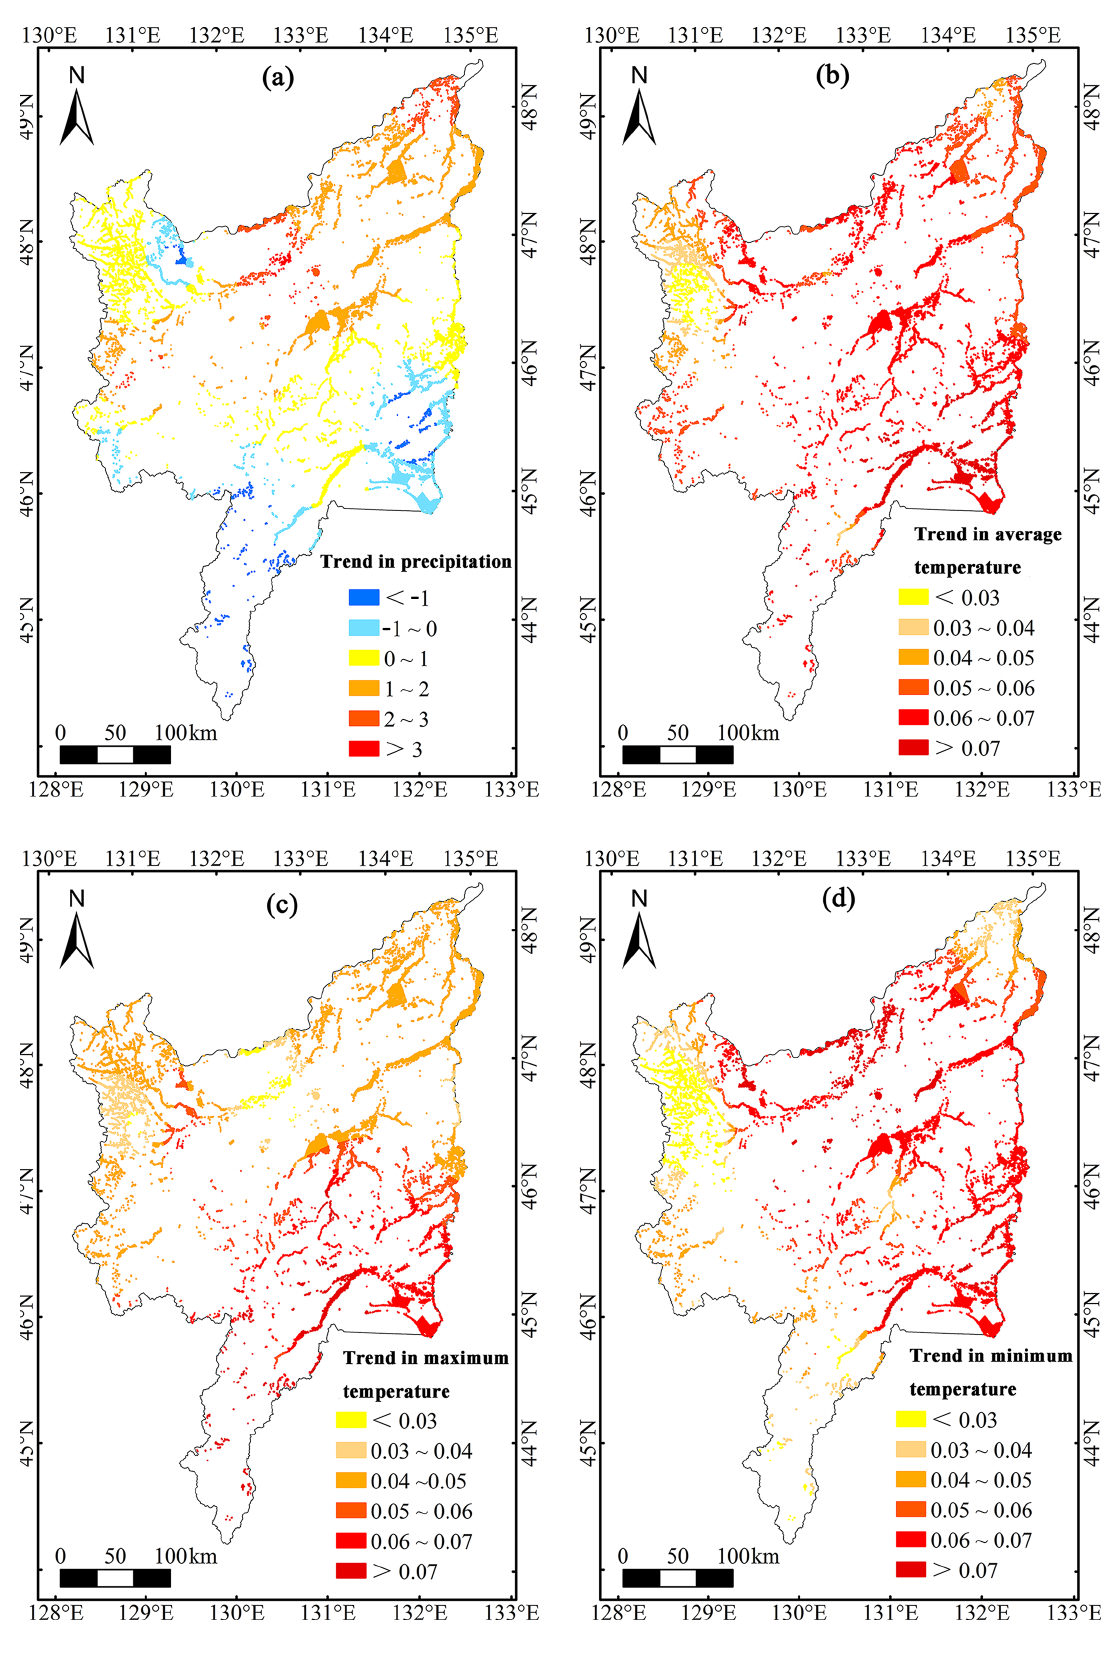
Figure 8. Change trends in July ( a ) precipitation (mm/year), ( b ) T mean (°C/year), ( c ) T max (°C/year) and ( d ) T min (°C/year) in the study region from 2000 to 2020.